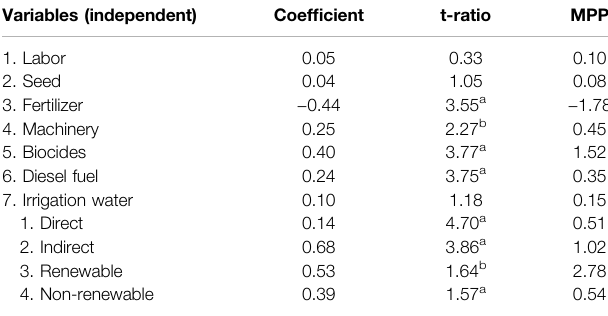
TABLE 3 | Regression results of energy inputs for cotton production. Variables (independent) Coef fi cient t-ratio